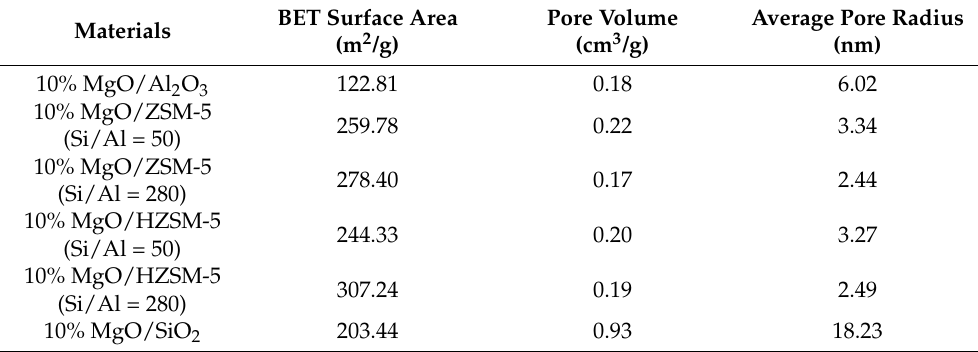
Table 3. The specific surface area, pore volume and average pore radius for MgO catalysts supported on various